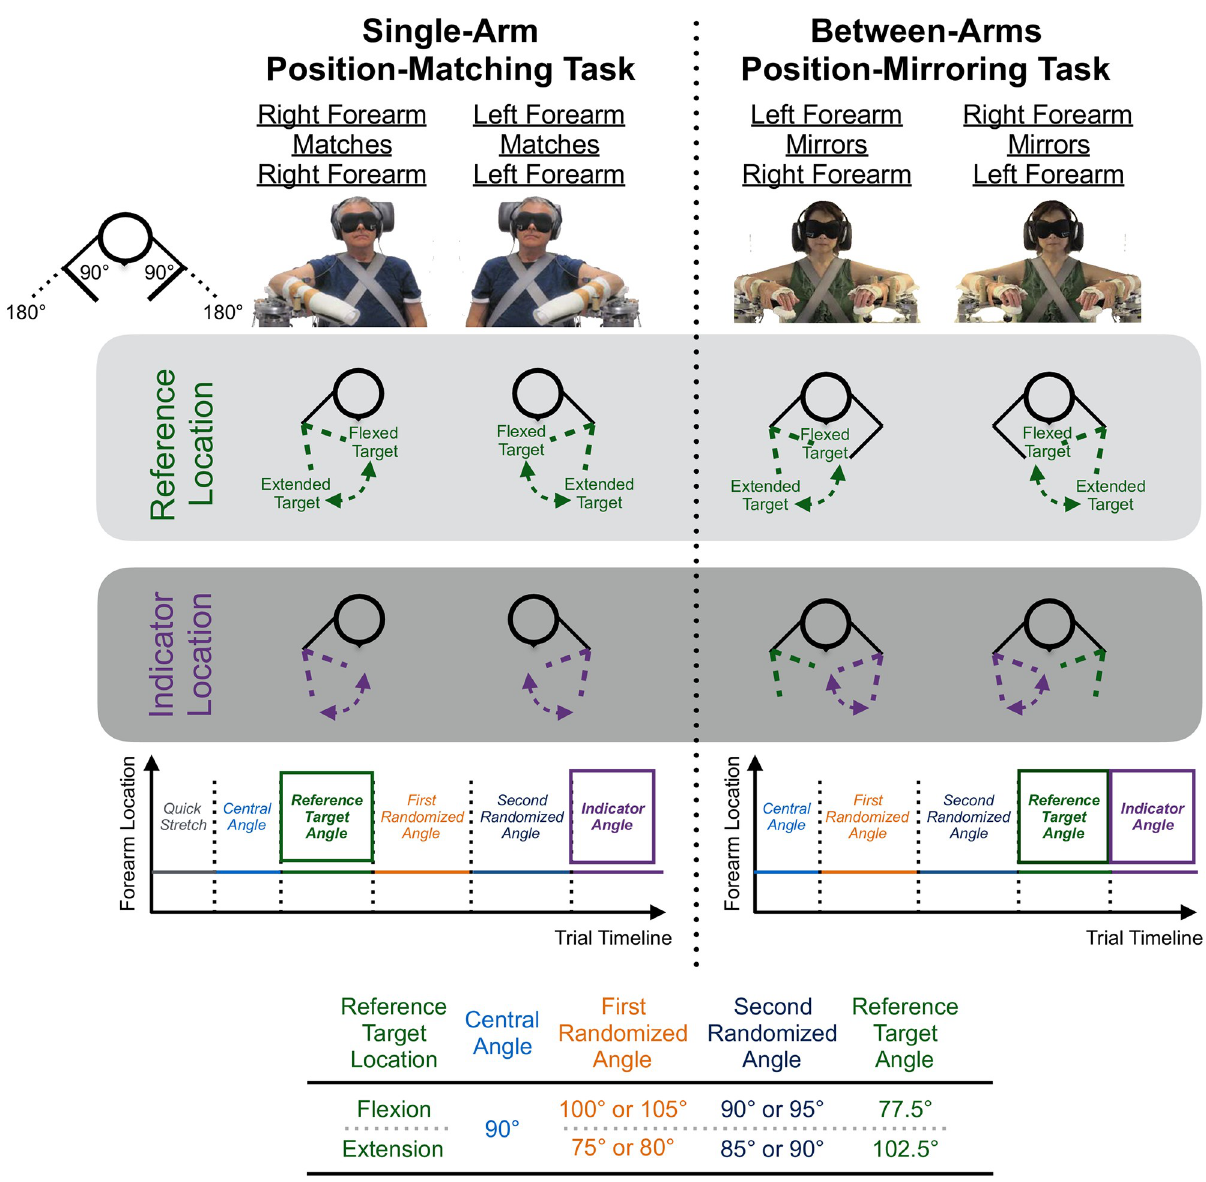
Fig 1. Experimental methods. Participants performed a (Left) single-arm position-matching task when using their right arm and their left arm and (Right) between-arms position-mirroring task when referencing their right arm and their left arm. The participant’s goal was to identify a reference target location with their reference forearm and then to return to that location with their same or opposite forearm. Angles to which the participant’s forearm rotated for each reference target location are indicated in the table at the bottom of the figure. The individuals shown in this figure provided written informed consent, as outlined in the PLOS consent form, to publish their photos. Images are adapted from Gurari et al., 2018 [48].